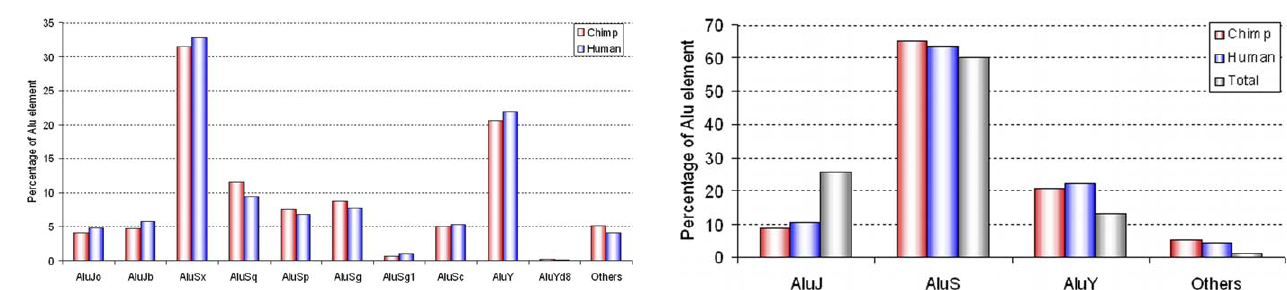
Figure 3. Comparison of Alu Subfamilies Involved in ARMD Events Proportion of Alu elements involved in chimpanzee-specific (red bars) and human-specific (blue bars) ARMD events versus proportion of total Alu elements in each subfamily in the chimpanzee genome (gray bars).